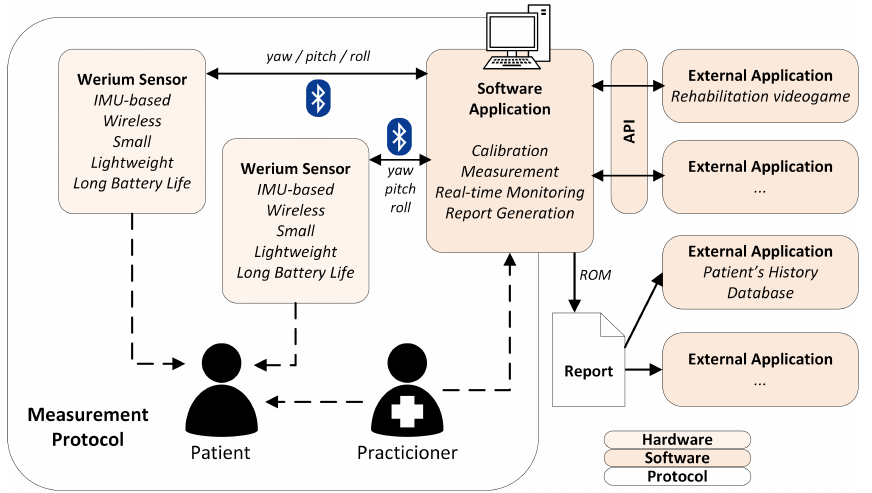
Figure 2. Complete solution